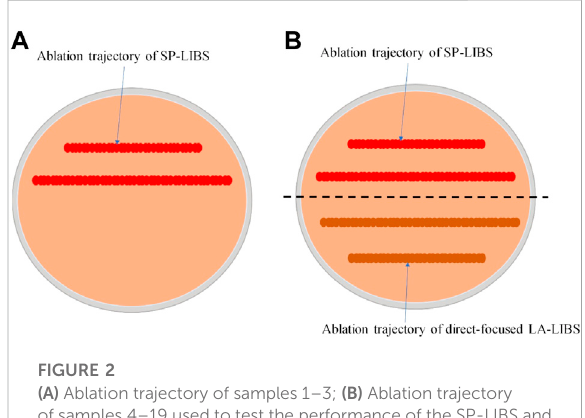
FIGURE 3 Characteristic spectrum of